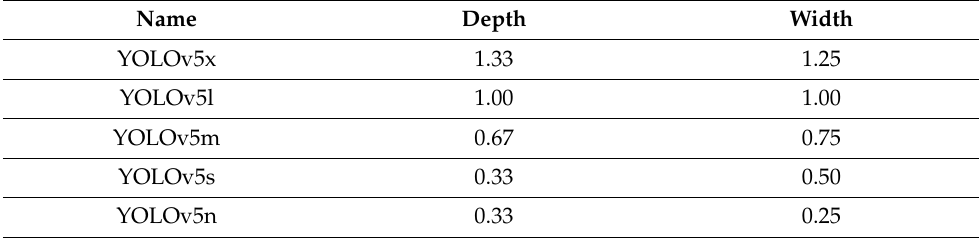
Figure 7. Categories of YOLOv5. Table 1. Scale ratios of YOLOv5 models.